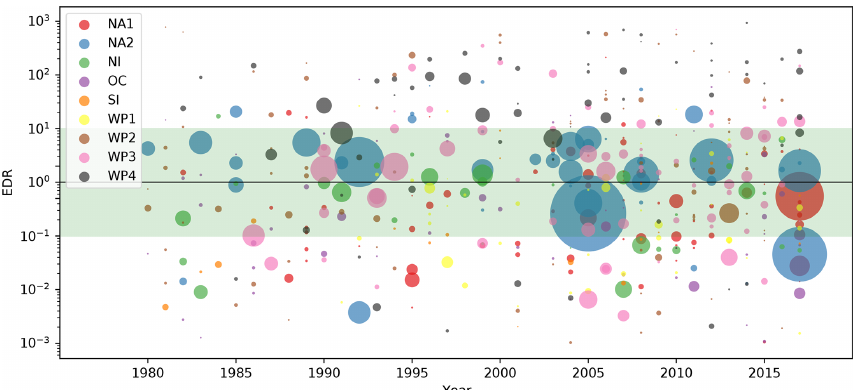
Figure A1. Event damage ratio (EDR) from 1980 to 2017 for 473 matched TC events worldwide. The nine calibration regions are differenti- ated by color. The area size of the dots represents the absolute normalized reported damage (NRD) per event. The green shading demarcates the range from EDR = 0.1 to 10. Regions by color: red: the Caribbean with Central America and Mexico (NA1); blue: the USA and Canada (NA2); green: North Indian Ocean (NI); purple: Oceania with Australia (OC); orange: South Indian Ocean (SI); yellow: South East Asia (WP1), brown: the Philippines (WP2); rose: mainland China (WP3); black: the rest of the north West Pacific Ocean (WP4).